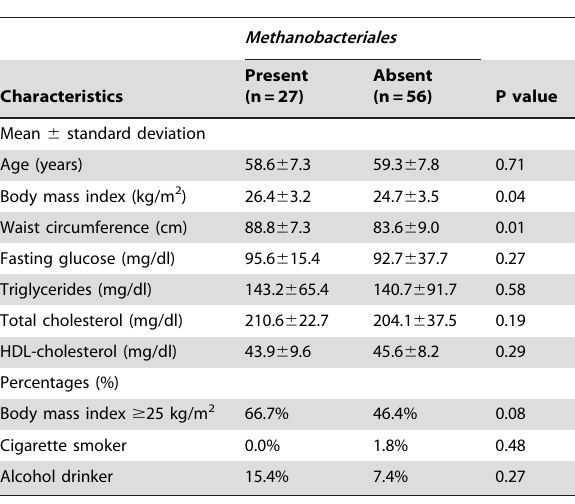
Table 1. General characteristics by presence of Methanobacteriales (n =83).